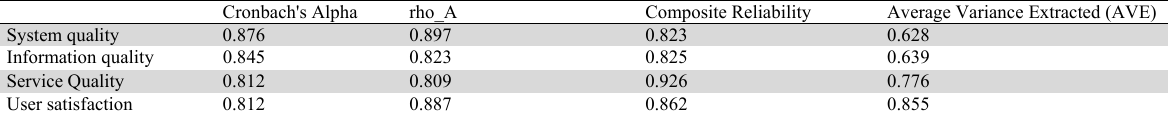
Construct Reliability and Validity